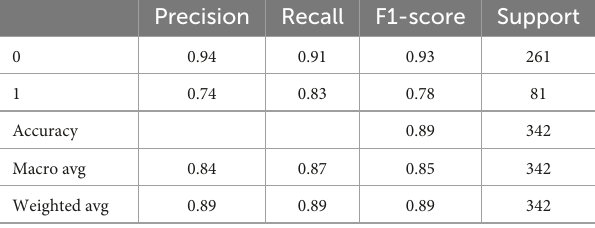
TABLE 8 SVM model quality after